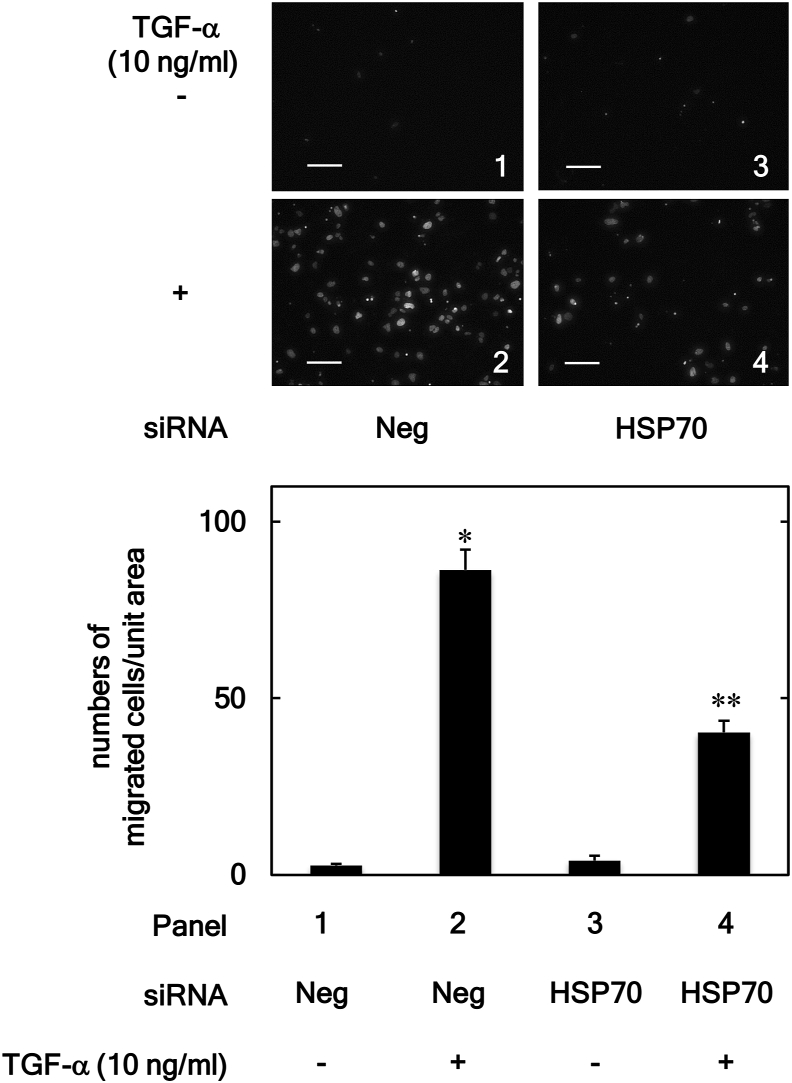
Effects of HSP70-siRNA on the TGF-α-induced HuH7 cell migration. The HSP70-siRNA (HSP70) or negative control-siRNA (Neg) transfected cells were stimulated by TGF-α (10 ng/ml) or vehicle for 24 h. The migrated cells were stained with DAPI for the nucleus and then photographed by fluorescent microscopy at a magnification of 20× (upper panel) and counted (bar graph). Each value represents the mean ± SD of triplicate determinations. ∗p < 0.05, versus column 1; ∗∗p < 0.05, versus column 2. Scale bar: 100 μm.